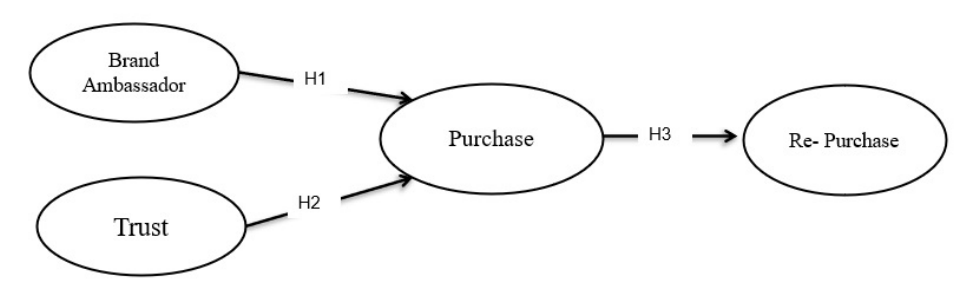
Fig. 1. Conceptual